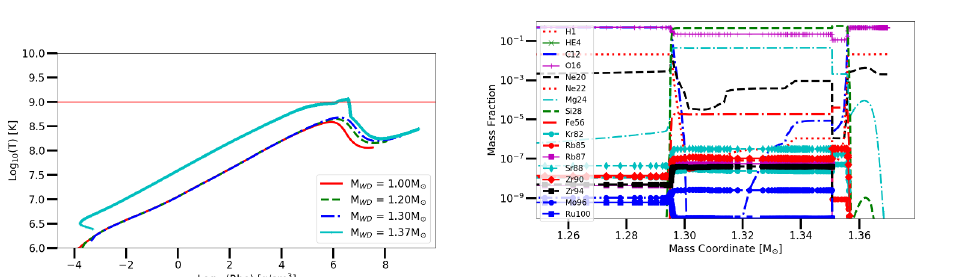
Figure 2. The neutron-capture isotopes produced on the top of the WD at the end of surface C- burning when adopting a 12 C + 12 C reaction rate increased by a factor of